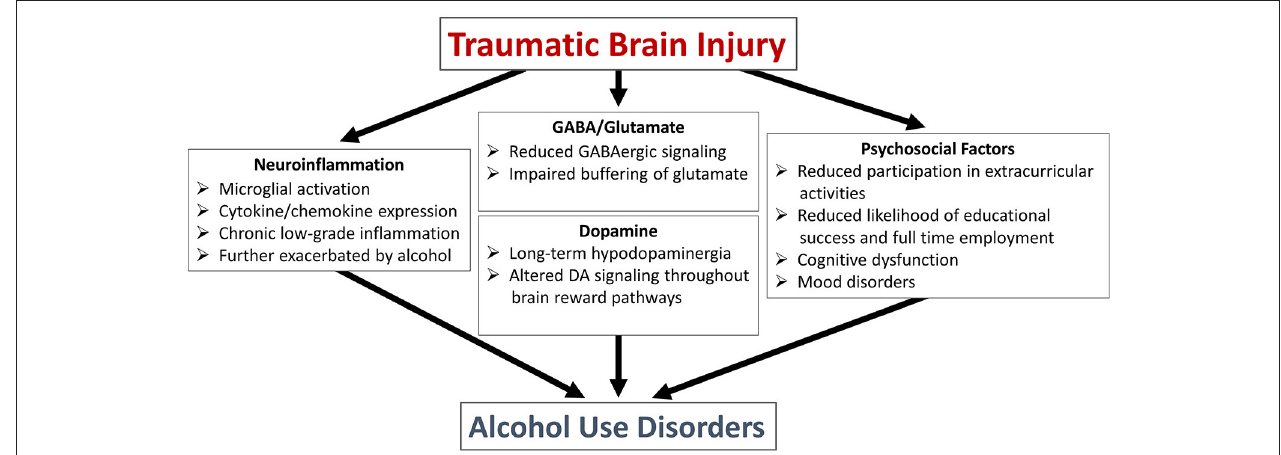
FIGURE 1 | Potential mechanisms linking traumatic brain injury to alcohol use